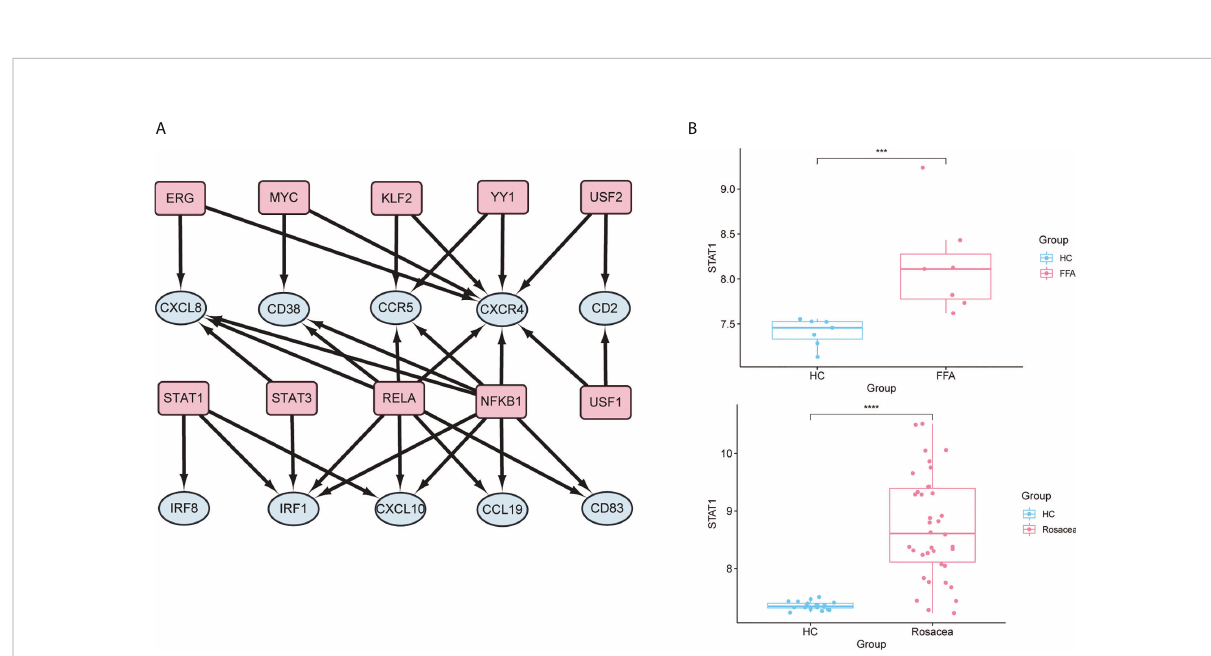
FIGURE 8 Prediction and veri fi cation of TFs: (A) TF regulatory network. TFs were marked in pink, and the hub genes were marked in blue. (B) The expression level of STAT1 in FFA and rosacea; ***p < 0.001, ****p < 0.0001. TF, transcription factor; FFA, frontal fi brosing